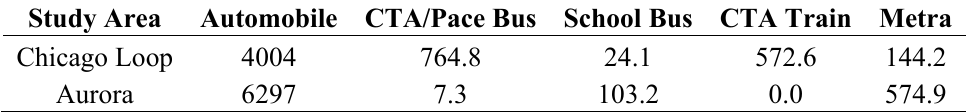
6. Annual mileage traveled per person (miles/person/year) by different transportation modes in the two study areas. Study Area